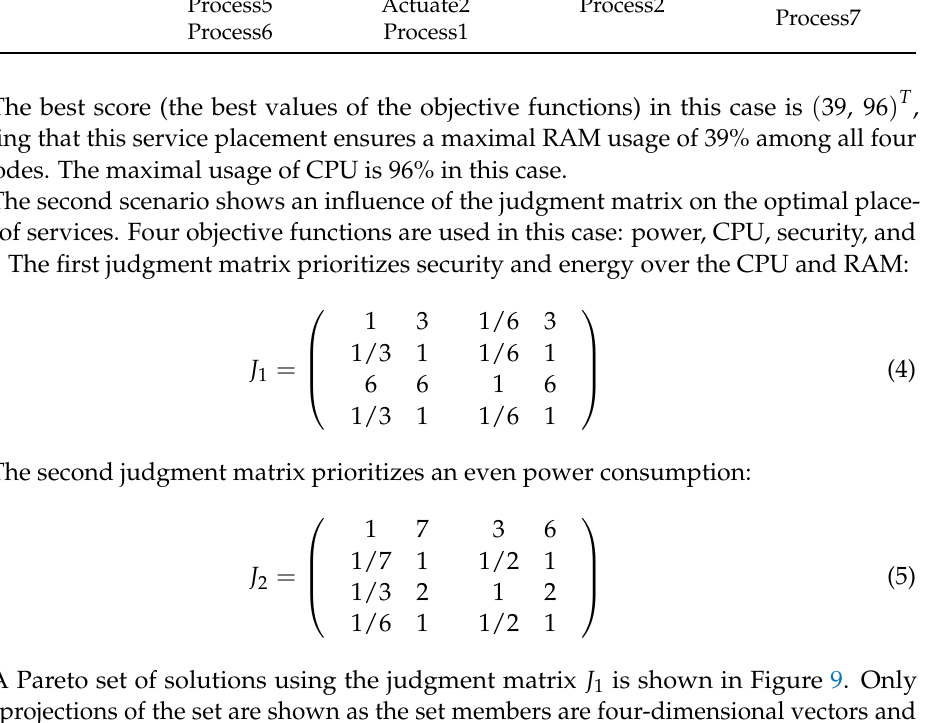
Fog1 Fog2 Fog3 Fog4 Actuate3 Process4 Process5 Process6